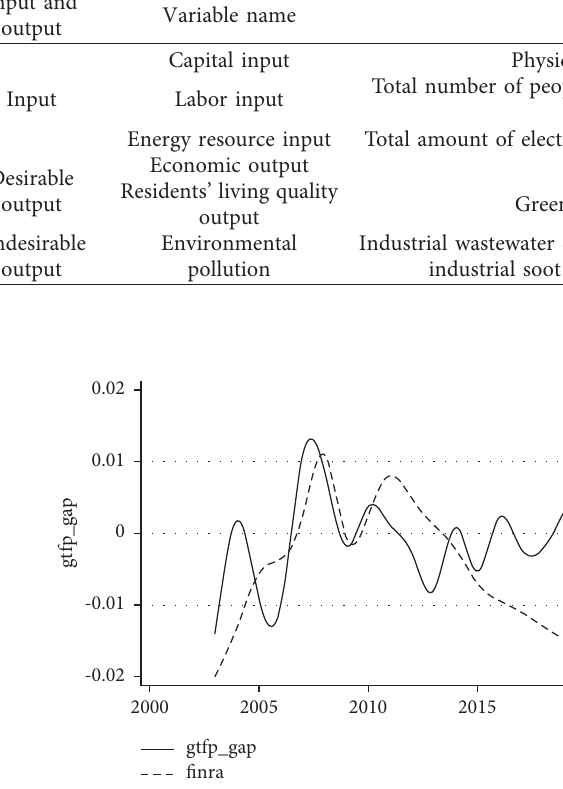
Figure 1: Binary curve of the gap between the financial development level and the gap of green